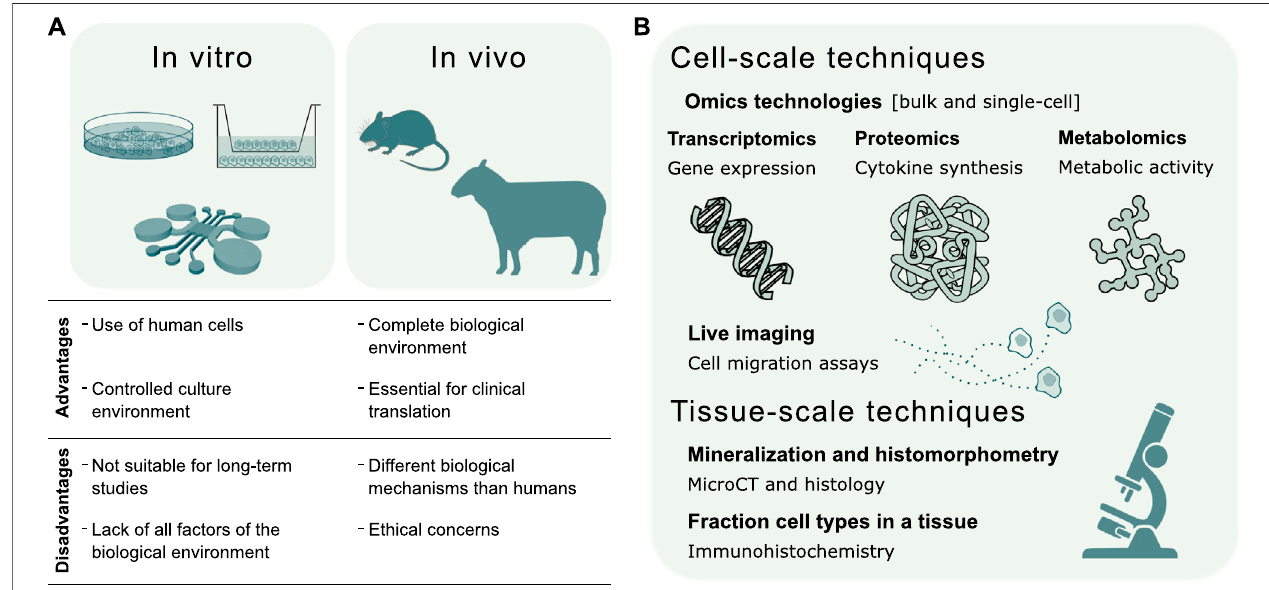
FIGURE 3 | Validation of in silico models of the in fl ammatory response in bone healing. (A) Summary of in vitro and in vivo experimental techniques to validate the predictivecapacityof insilico models.Thechoiceoftheexperimentalmodeldependswhetherthevalidationregardsaspeci fi cmechanismortheglobalresponse. Invitro modelsinvestigatesinglebiologicalmechanisms, suchasthechemoattractant effectofin fl ammatorymarkersorspeci fi ccelltypes. Invivo modelsevaluatetheeffectsof individual factors, such asthe depletion ofa celltype, on the complete biological response. (B) Experimental techniques for the validation of in silico models canbe broadly divided into cell and tissue-scale techniques. The former validate in silico models of molecular mechanisms regulating cell function and models of cell migration dynamics. The latter validate in silico models of the repair and remodeling phase, by quantifying bone histomorphometric parameters, and models describing cellular composition in the fracture